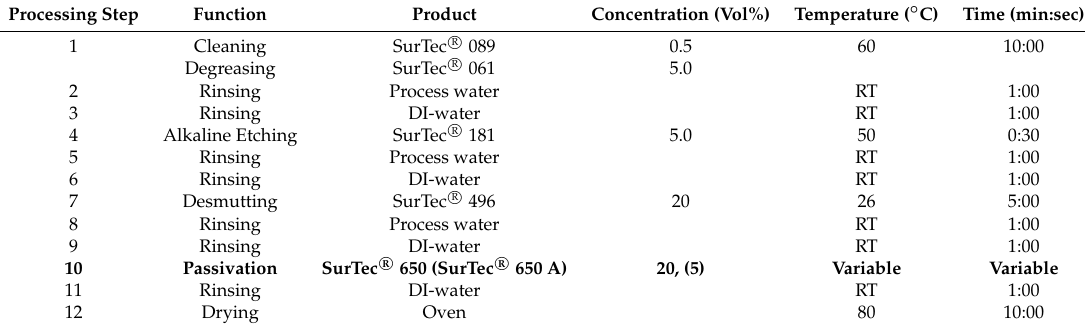
Table 1. Overview of the process steps for the Cr–Zr coatings. The bold printed step 10 is different for each sample in a way presented in Table 2.